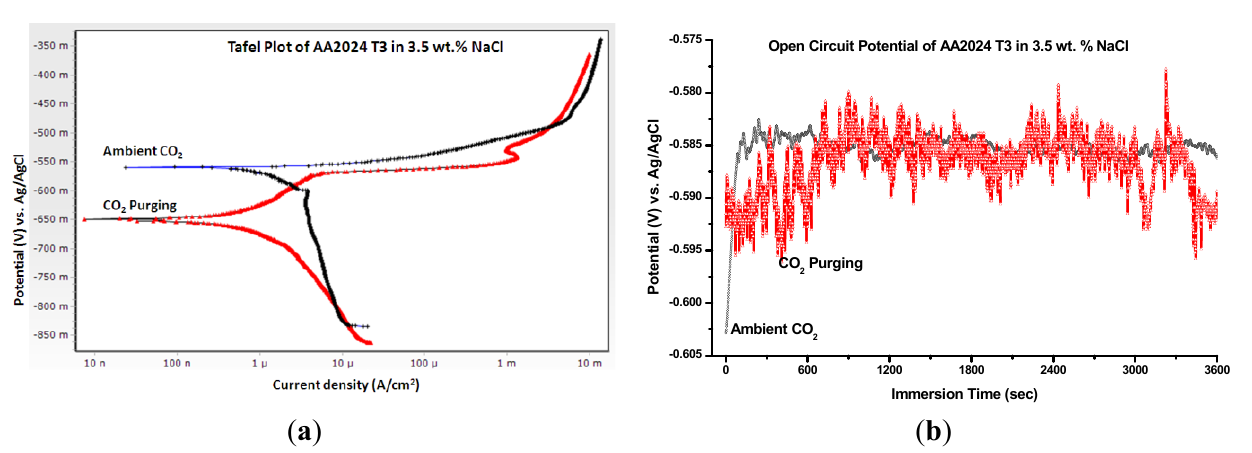
Figure 8. Potentiodynamic polarization curves ( a ) and OCP ( b ) of AA 2024-T3 coupons in 3.5 wt% NaCl